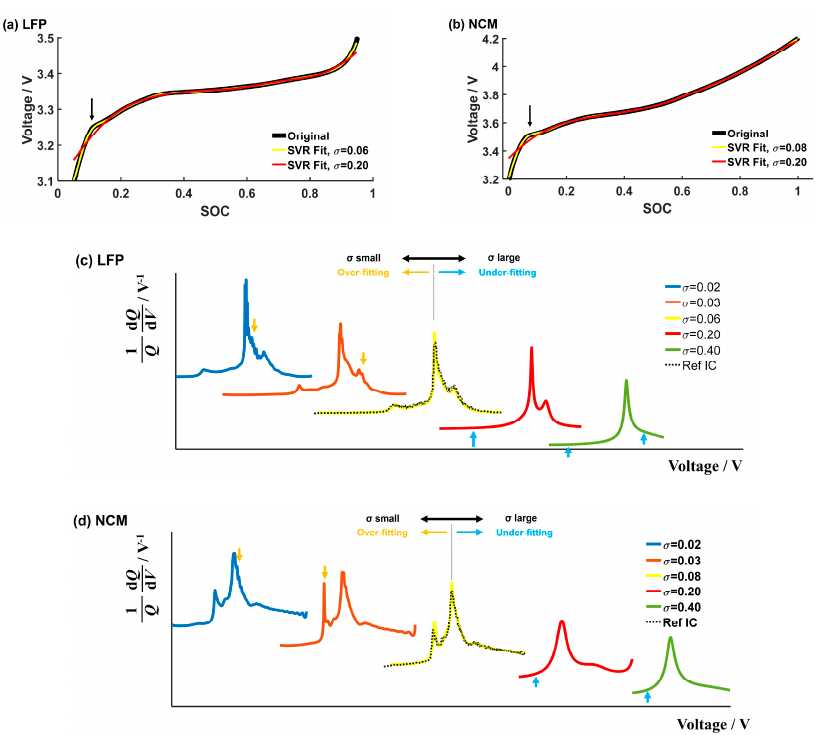
Figure 8. The influence of the σ in the Gaussian kernel on the accuracy of curve fitting. ( a ) The fitting results of the voltage curve for Cell A with LFP cathode, σ = 0.06 and 0.20. ( b ) The fitting results of the voltage curve for Cell B with NCM cathode, σ = 0.08 and 0.20. ( c ) The fitting results of the IC curve for Cell A with LFP cathode, from small σ = 0.02 to large σ = 0.40. ( d ) The fitting results of the IC curve for Cell B with NCM cathode, from small σ = 0.02 to large σ = 0.40.